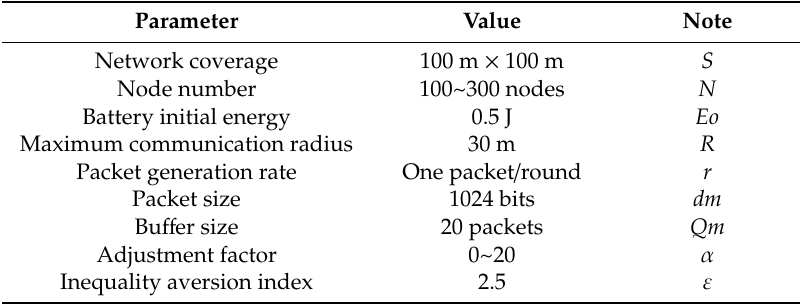
Table 1. Simulation Parameters